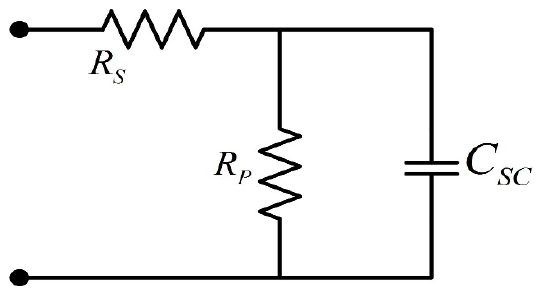
Figure 4. Supercapacitor